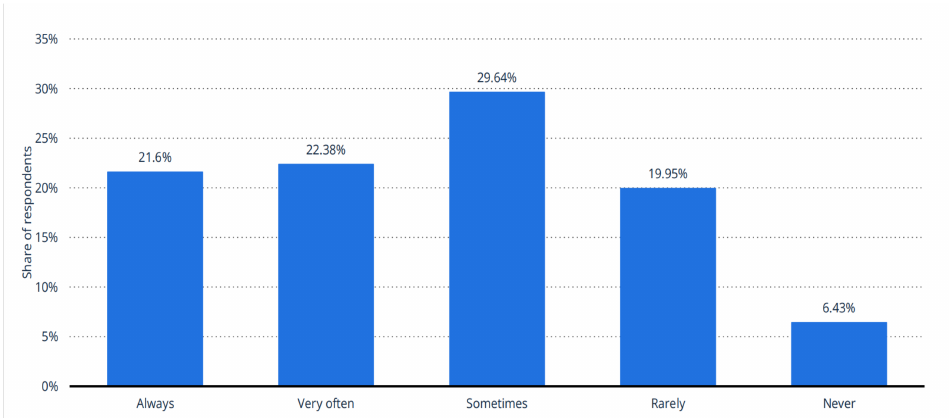
Figure 1. Do you pay attention to any of the following while grocery shopping? (Relevant product information in China 2019).